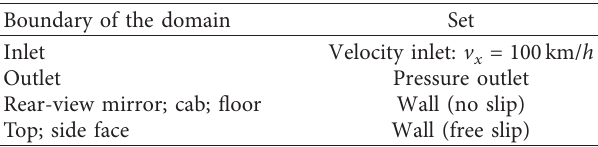
Table 2: Set of the boundary condition.